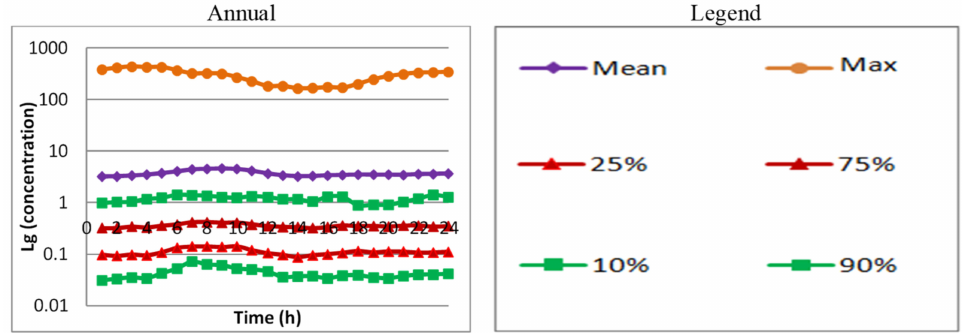
Figure 17. Spatial and diurnal variations of the annual and seasonal ensembles of surface FPRM